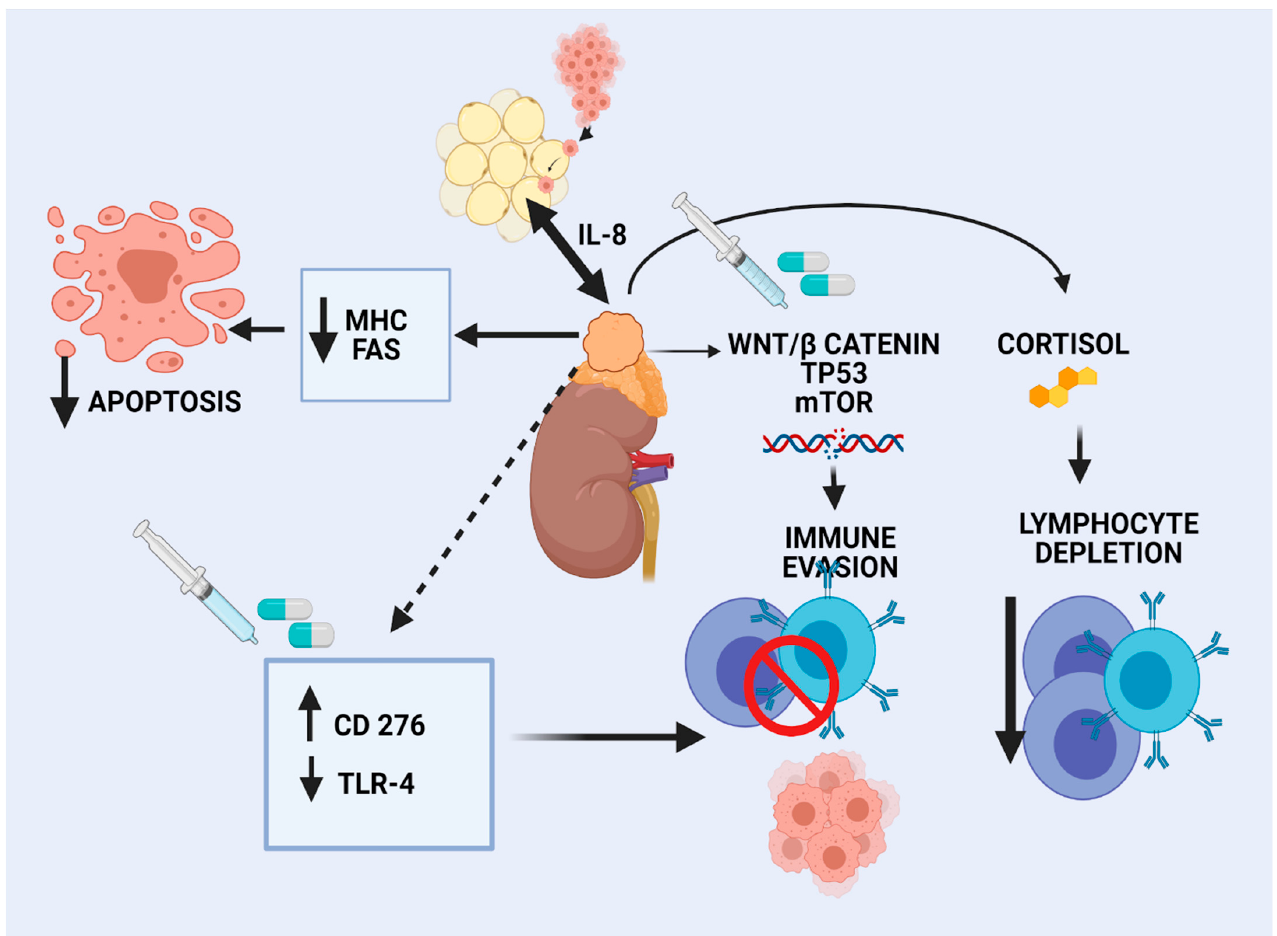
Figure 1. Immune microenvironment in adrenocortical carcinoma.